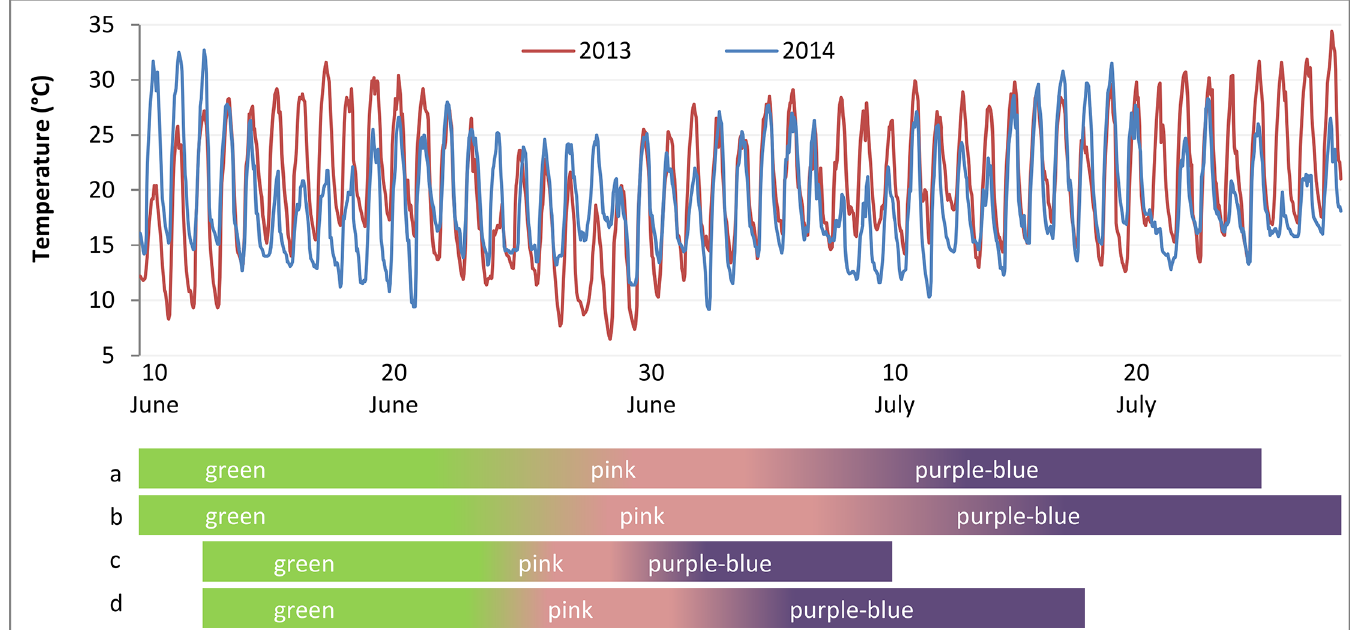
Fig 1. Daily temperatures measured during the ripening period of Vaccinium berries in two consecutive seasons (2013 – 2014). Colored bars show the ripening process, through green, pink and purple-blue (fully ripe) stages of bilberries in 2013 (a), in 2014 (c) and blueberries in 2013 (b), in 2014